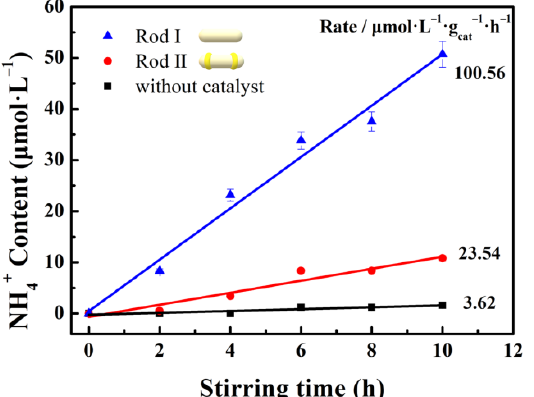
Figure 6. Tribocatalytic N 2 fixation performance of g-C 3 N 4 with the different kinds of rods or without catalyst.